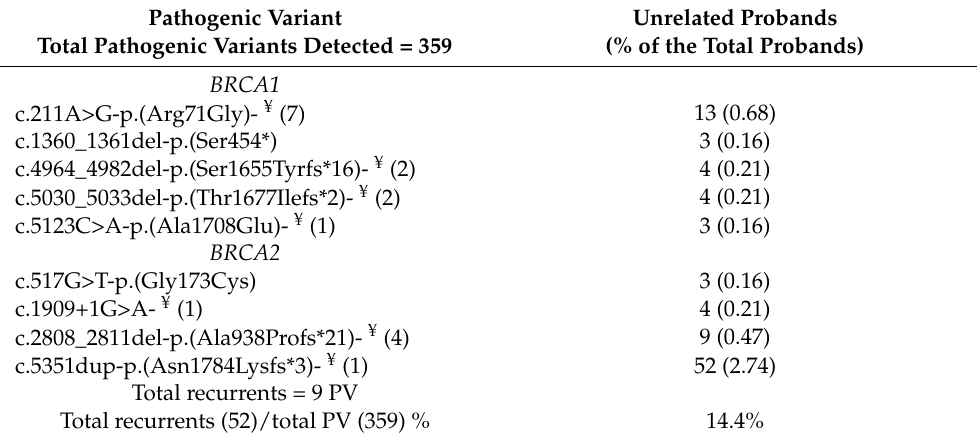
Table 7. Recurrent pathogenic variants in BRCA1/2 detected in 1900 probands with personal and/or family history of breast/ovary